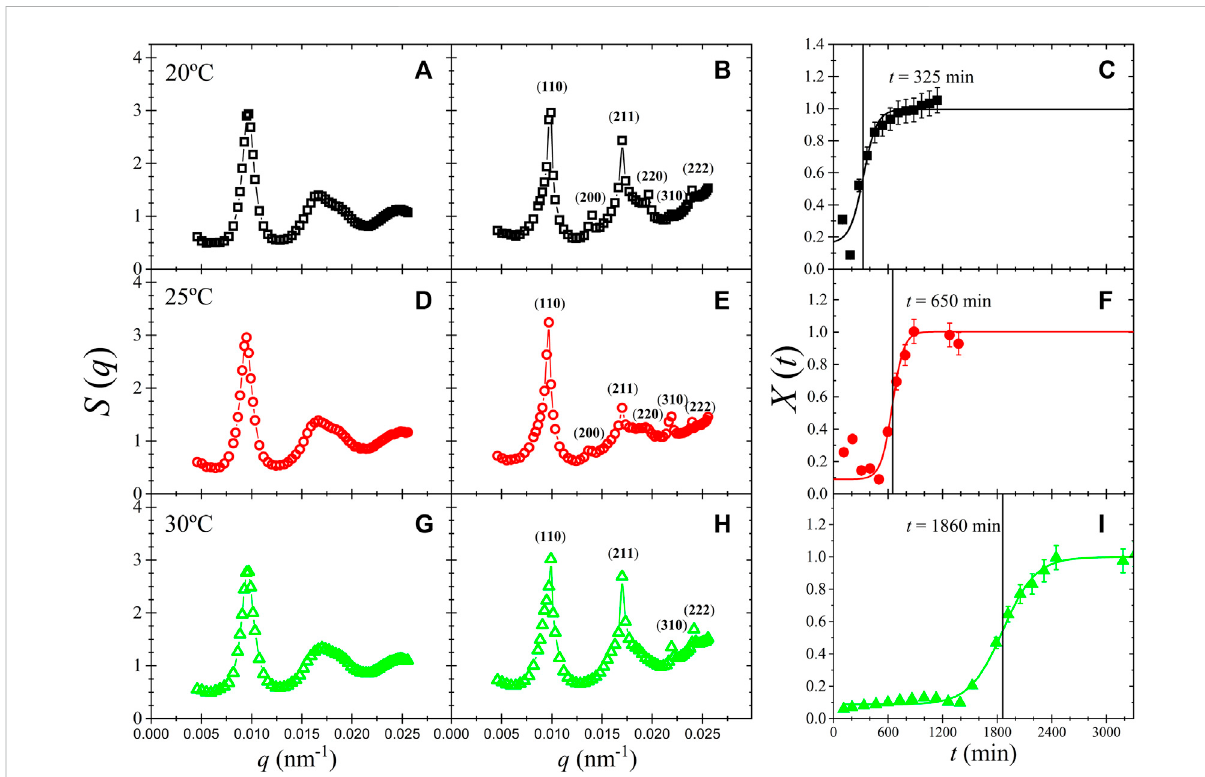
FIGURE 4 (A) Initial measured static structure factor, S ( q ), right after quenching, (B) Final equilibrium static structure, (C) time evolution of the degree of crystallinity(symbols)alongwithaBoltzmann fi t(continuousline)at20 ° C. (D) Initial S ( q )rightafterquenching, (E) Finalequilibriumstaticstructure, (F) time evolution of the degree of crystallinity (symbols) along with a Boltzmann fi t (continuous line) at 25 ° C. (G) Initial S ( q ) right after quenching, (H) Finalequilibriumstaticstructure, (I) timeevolutionofthedegreeofcrystallinity(symbols)alongwithaBoltzmann fi t(continuousline)at30 ° Cfor sample KPS0.6 at n = 2.4 particles/µm 3